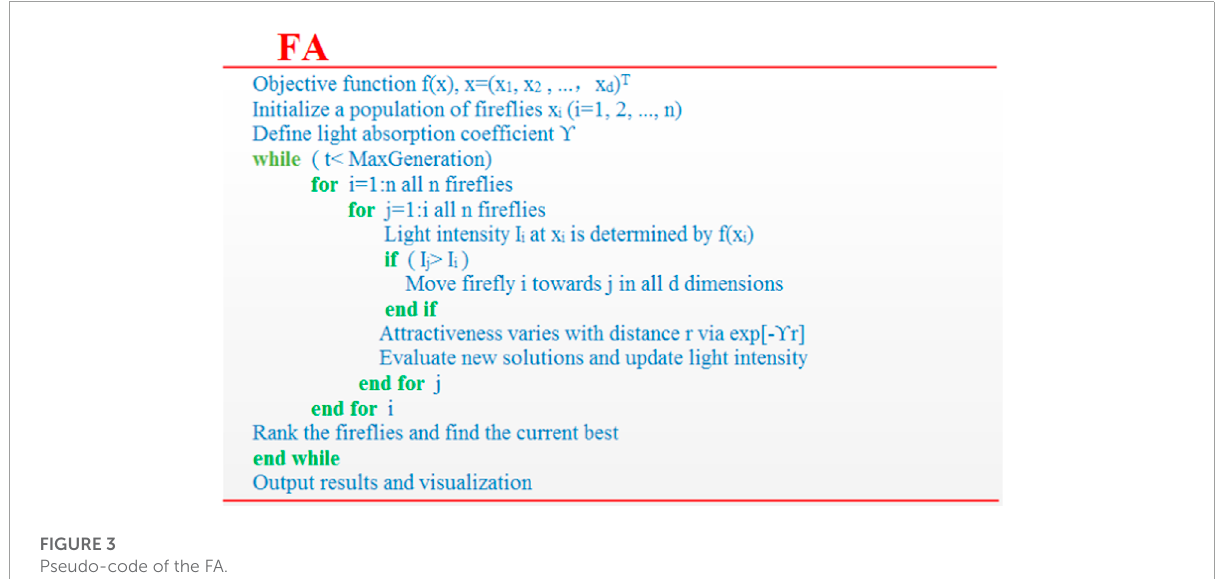
FIGURE 3 Pseudo-code of the